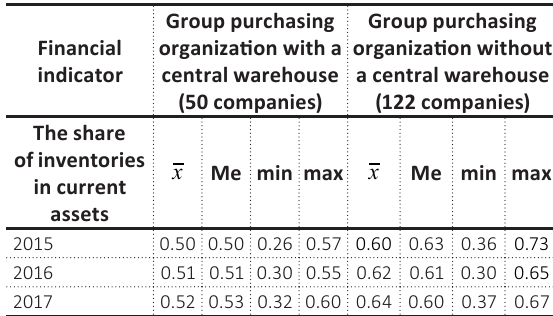
Table 3. Average results of financial